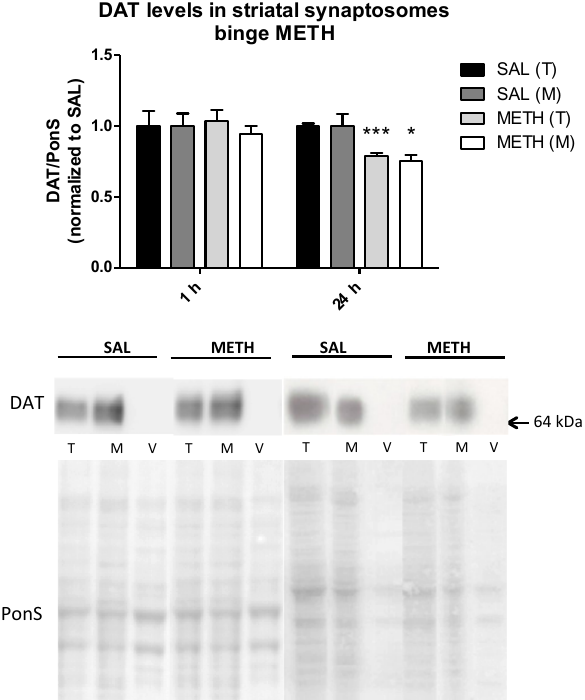
Figure 6. The effect of binge intraperitoneal (i.p.) METH on the immunoreactivity of dopamine transporter (DAT) in striatal synaptosomal fractions. Binge METH (4 × 10 mg/kg, every 2 h, i.p.) decreased DAT immunoreactivity at 24 h in total synaptosomal ( − 21%, *** p < 0.001) and membrane-endosomal ( − 25%, * p < 0.05) fraction. Abbreviations: M, membrane fraction; METH, methamphetamine; PonS, Ponceau S; SAL, saline; T, total fraction; V, vesicular